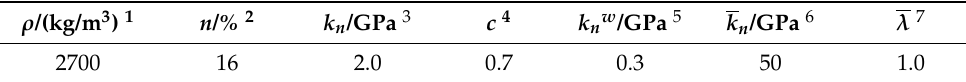
Figure 3. Numerical model for triaxial compression test. Table 2. Basic meso parameters in model.